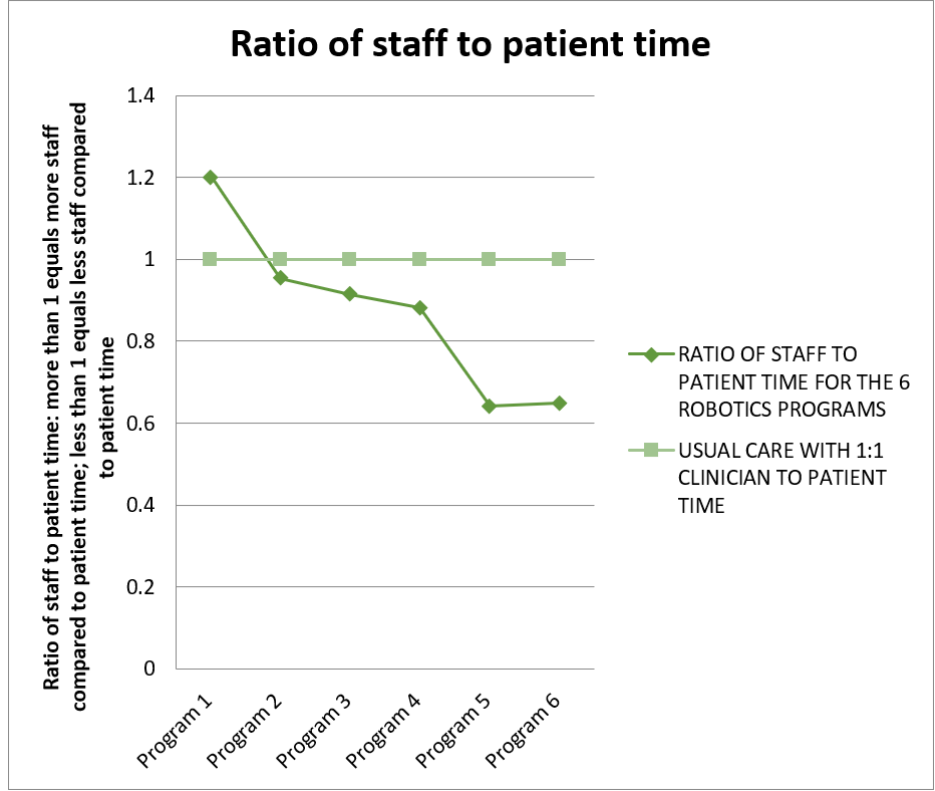
Figure 3. Ratio of staff to patient time.